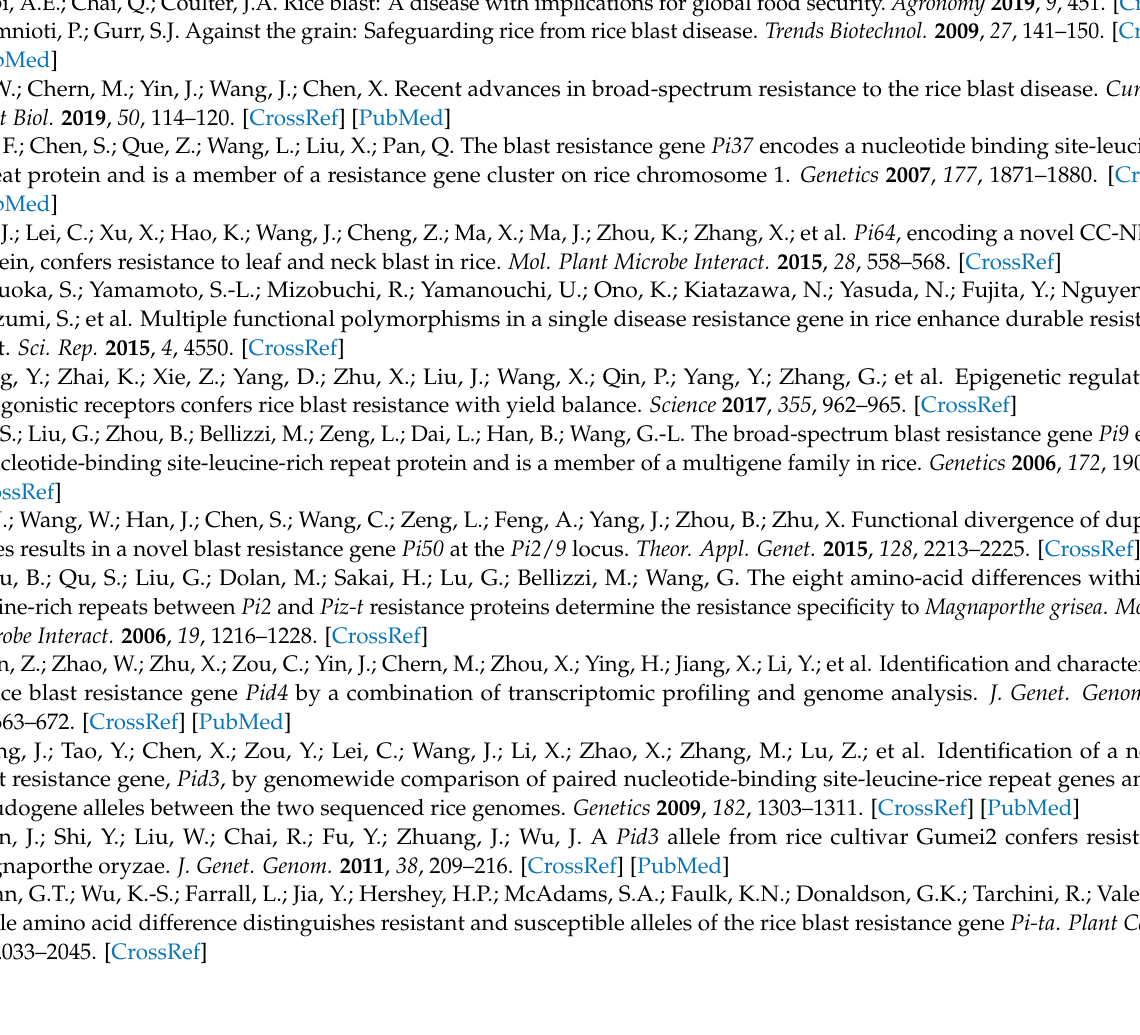
Table S2: The 0–9 scale for determining leaf blast resistance in rice. Table S3: Climate data collected from May 1 to September 30 in Hangzhou for 2019 and 2020. Table S4. Diseased scales of the two parents evaluated using each of the 14 isolates. Table S5: The information of the high-density linkage map. Figure S1: The LOD thresholds of the QTL for the LBR and the eight yield traits calculated with 1000 permutation tests ( p <